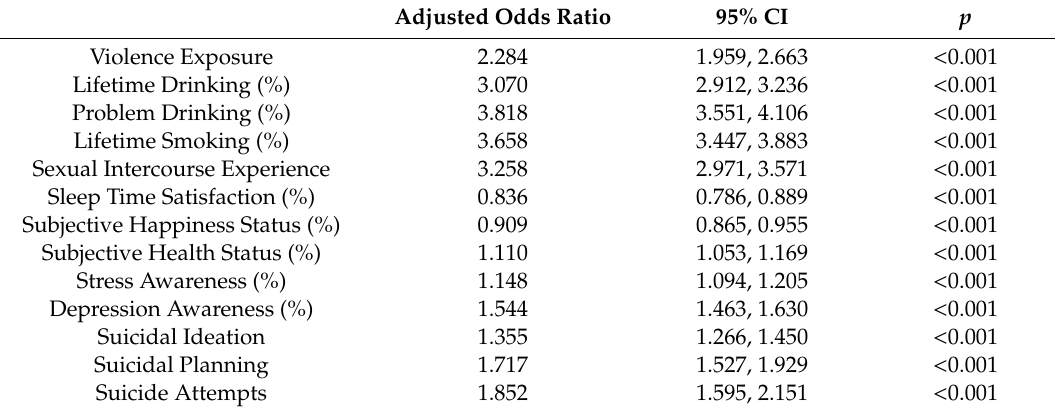
Table 3. Mental health and suicidal behavior by part-time experience after propensity score matching ( n =